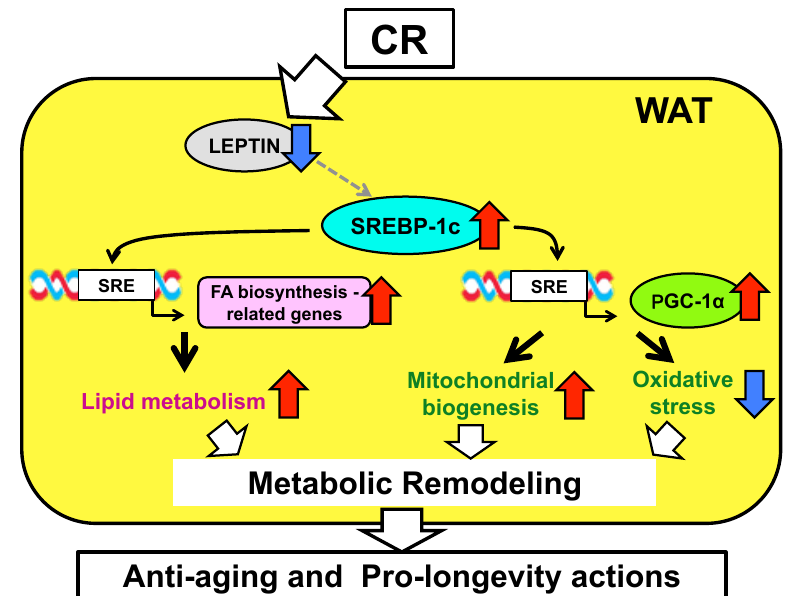
Figure 1. Summary of sterol regulatory element-binding protein 1c (SREBP-1c)-dependent mechanisms in the effects of caloric restriction (CR) in white adipose tissue (WAT). CR upregulates SREBP-1c, possibly via the suppression of leptin signaling. Upregulation of SREBP-1c enhances fatty acid (FA) biosynthesis and activates mitochondrial biogenesis and antioxidant capacity through the action of proliferator-activated receptor γ coactivator-1 α (PGC-1 α ), by binding sterol regulatory element (SRE) in the promoter region of genes involved in these processes. This causes metabolic remodeling in WAT, which contributes to the anti-aging and pro-longevity effects of CR. Red arrows and blue arrows mean “upregulation” and “downregulation”,